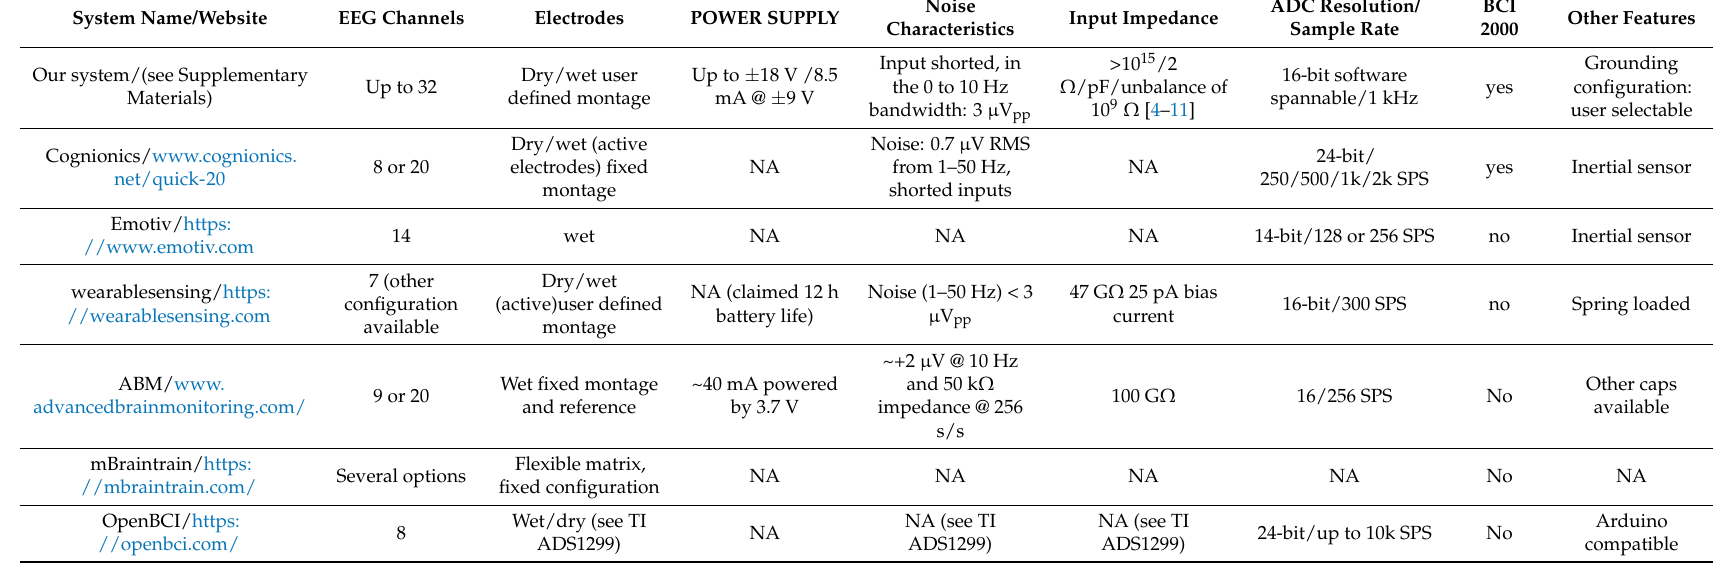
Table A1. Summary of compared hardware, our hardware is in